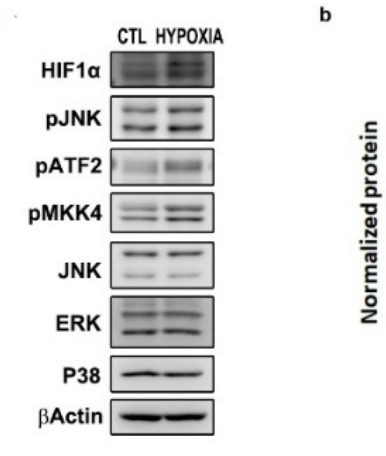
Int. J. Mol. Sci. 2022 , 23 , x FOR PEER REVIEW